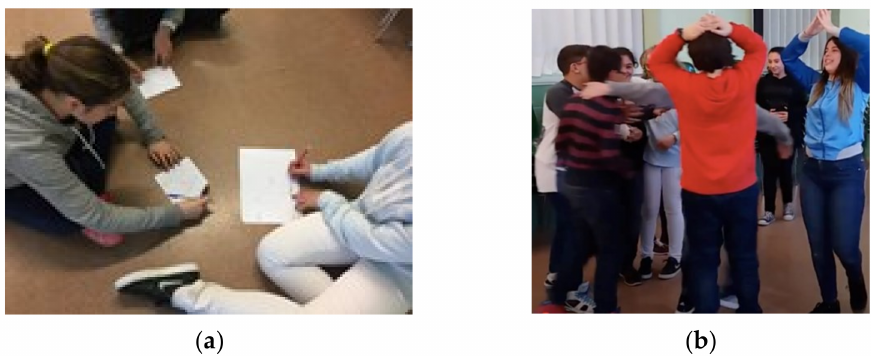
Figure 2. Pupils participating in A4. ( a ) Pupils drawing prediction graphs; ( b ) pupils playing the population game.